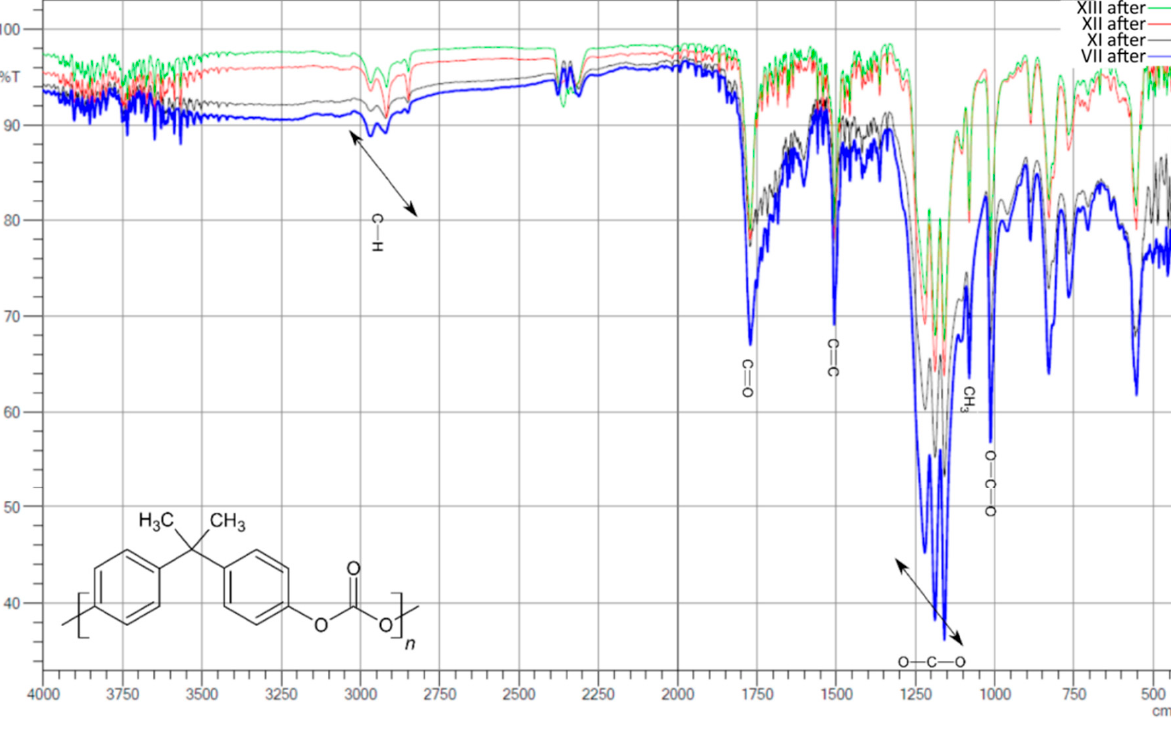
Figure 6. Compilation of IR spectra after aging for samples XIII, XII, XI, and VII .